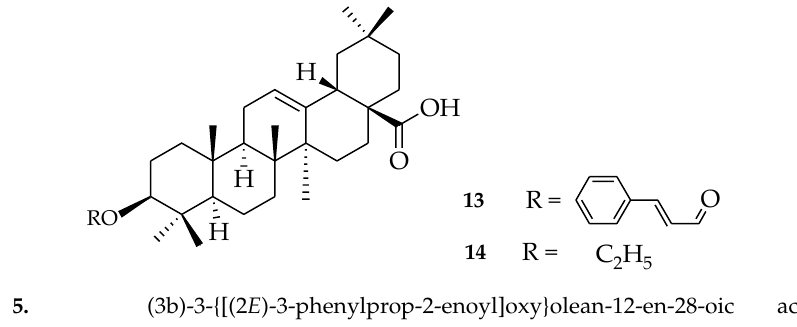
Figure 5. (3b)-3-{[(2 E )-3-phenylprop-2-enoyl]oxy}olean-12-en-28-oic acid ( 13 ), (3b)-3-ethoxyolean-12-en-28-oic acid ( 14 ).